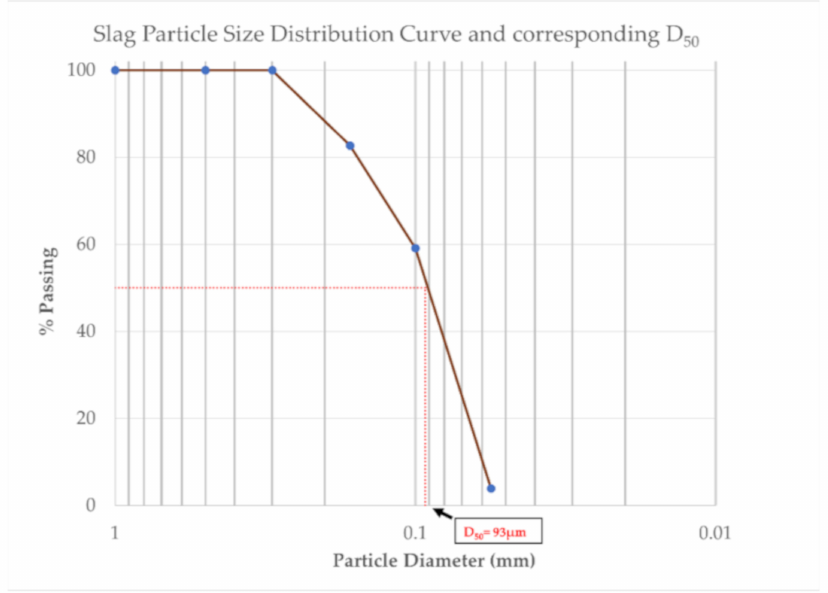
Figure 2. Particle size distribution and corresponding graphical estimation of the D50 of the Ca-rich slag used for the laboratory scale experiments of this study.